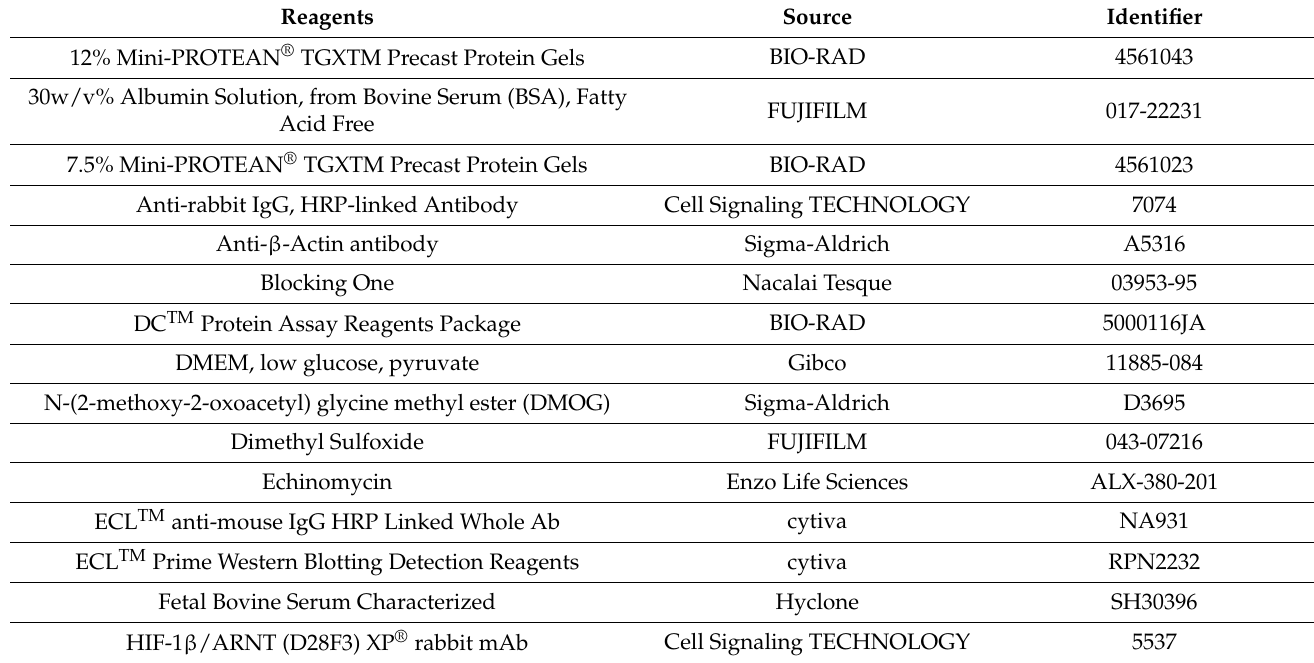
Table A1. Table of Key